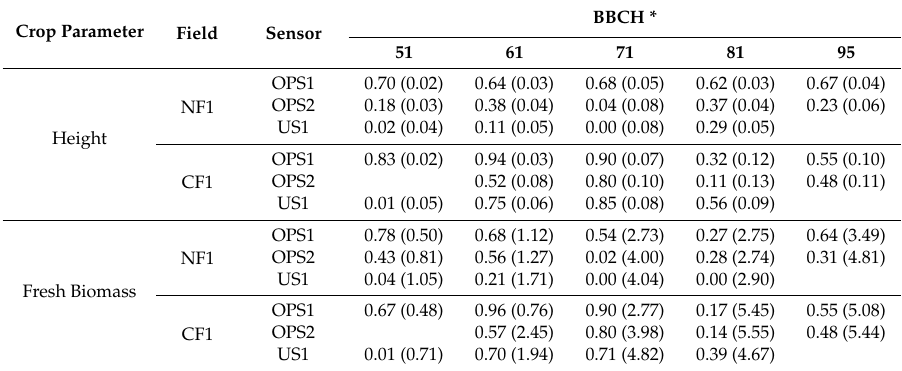
Table 4. Performance of crop sensors measured by coefficient of determination and root-mean-squared error to predict crop height and aboveground biomass in five crop